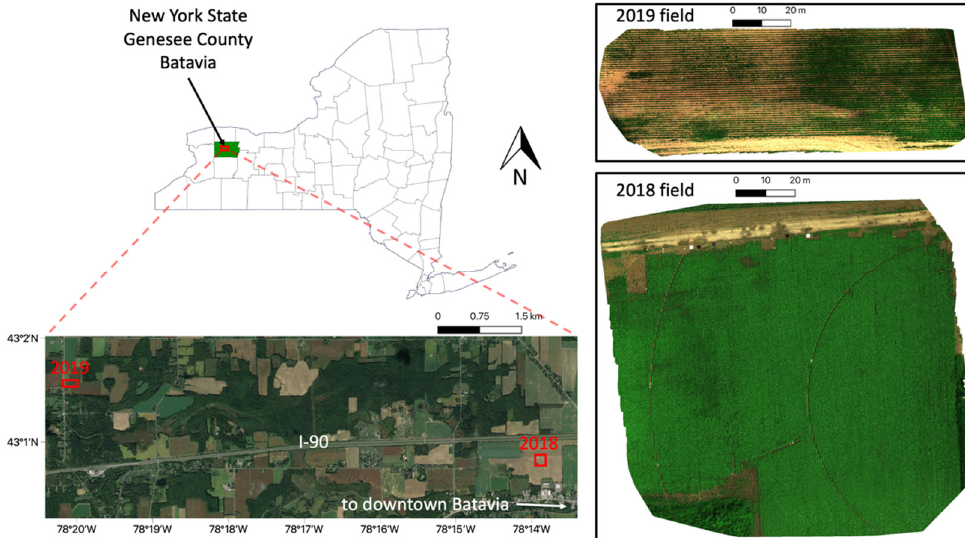
Figure 1. The 2018 and 2019 table beet field site locations in Batavia, New York, USA. Lower left map data: Google, Maxar Technologies.